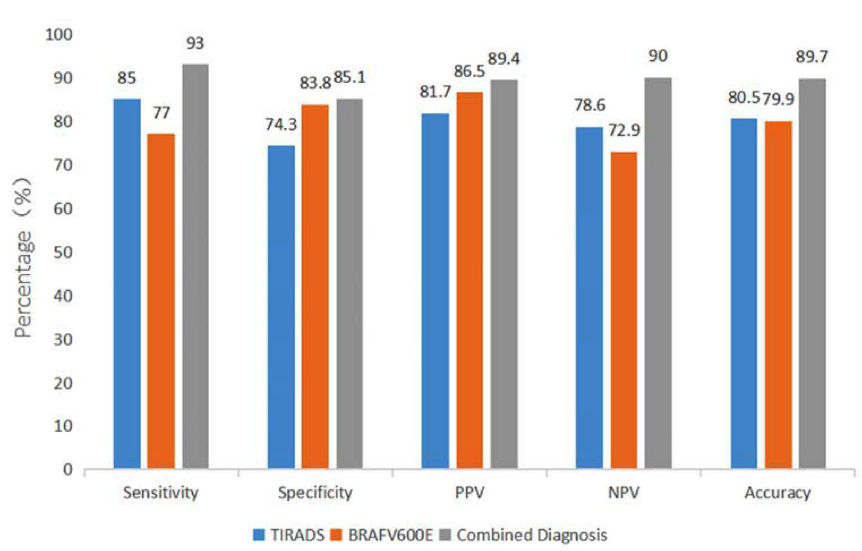
Figure 4. Comparison of diagnostic performance of TIRADS, BRAF V600E , and combination of the